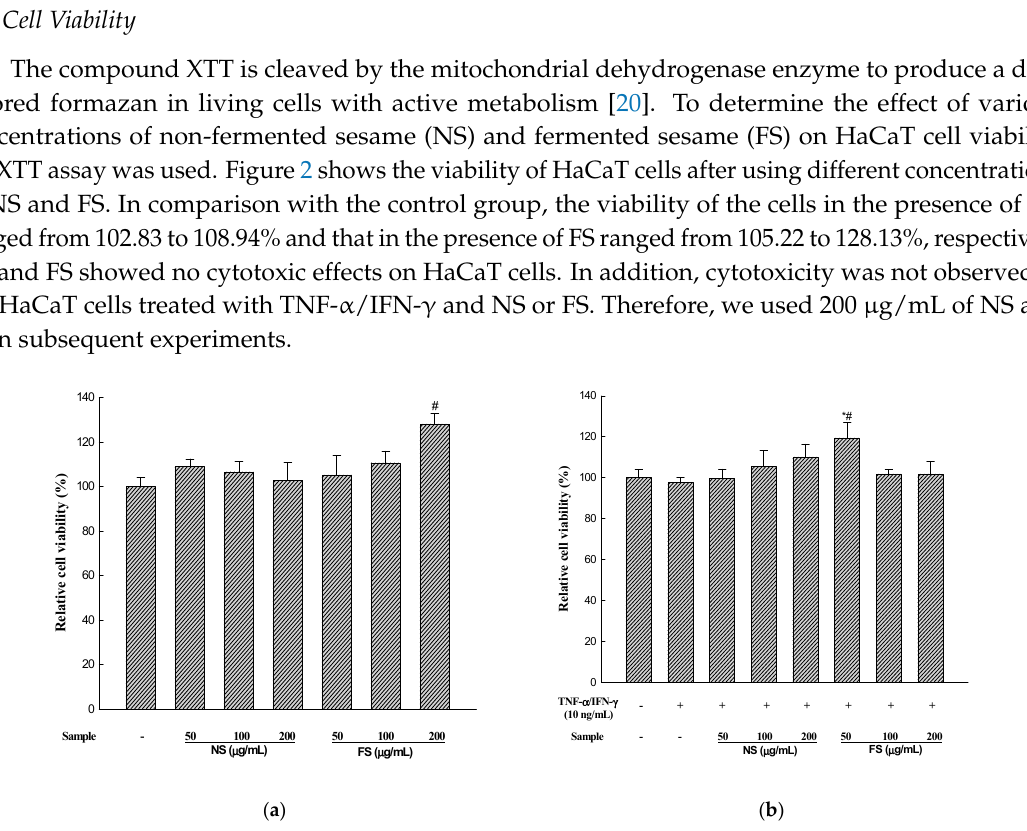
Figure 1. SDS-PAGE analysis of non-fermented sesame (NS) and fermented sesame (FS) proteins. Abbreviations: M, molecular weight standard maker; Lane 1, non-fermented sesame; Lane 2, fermented sesame.